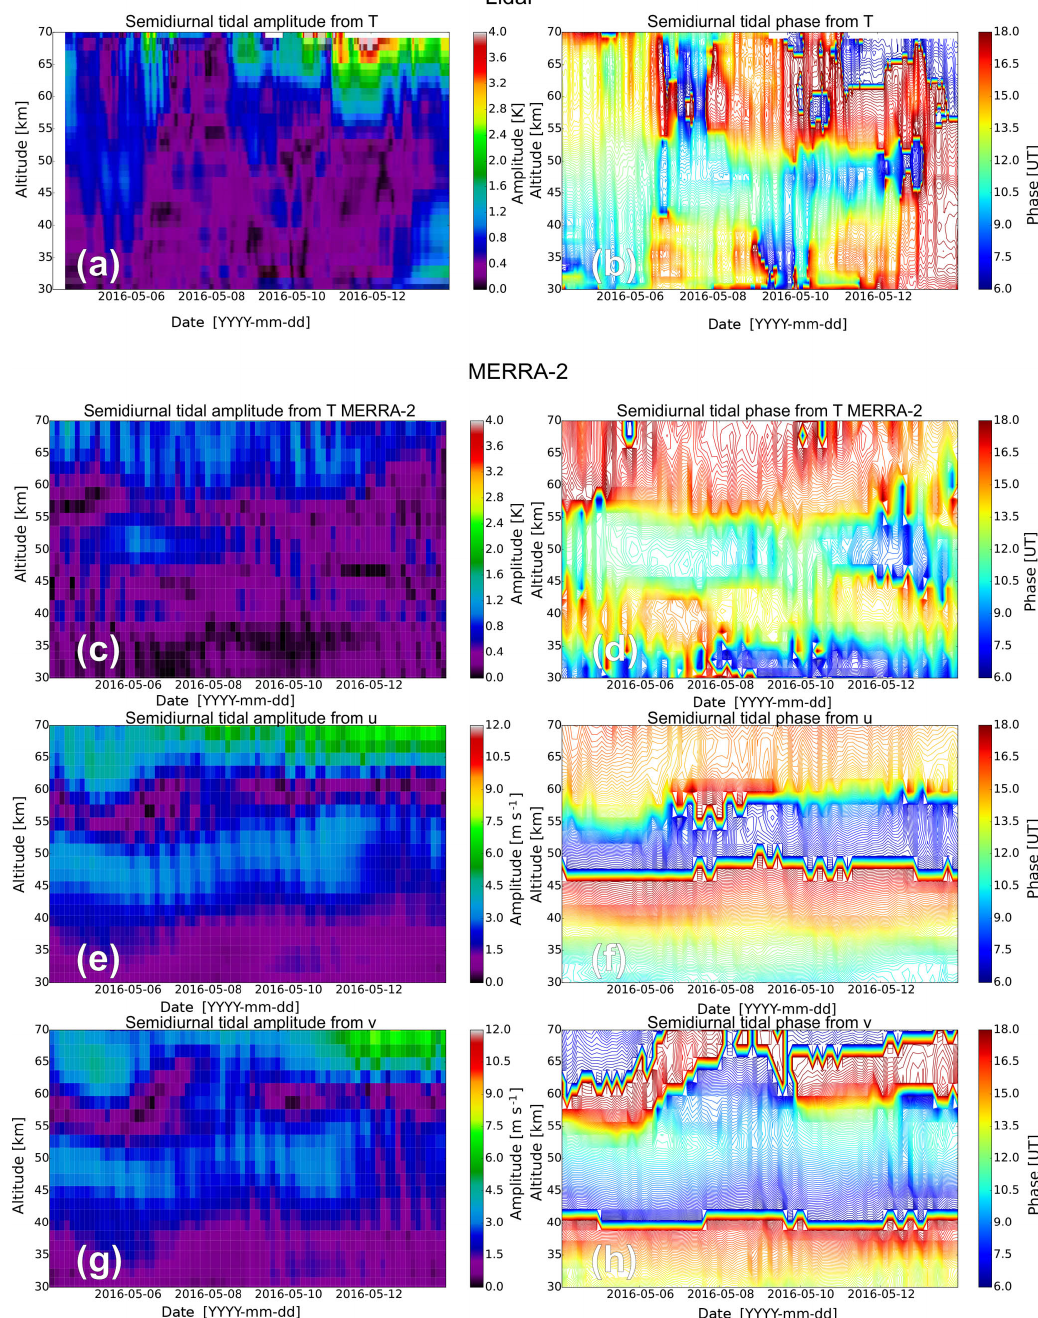
Figure 8. Same as Fig. 7 but for the semidiurnal tidal